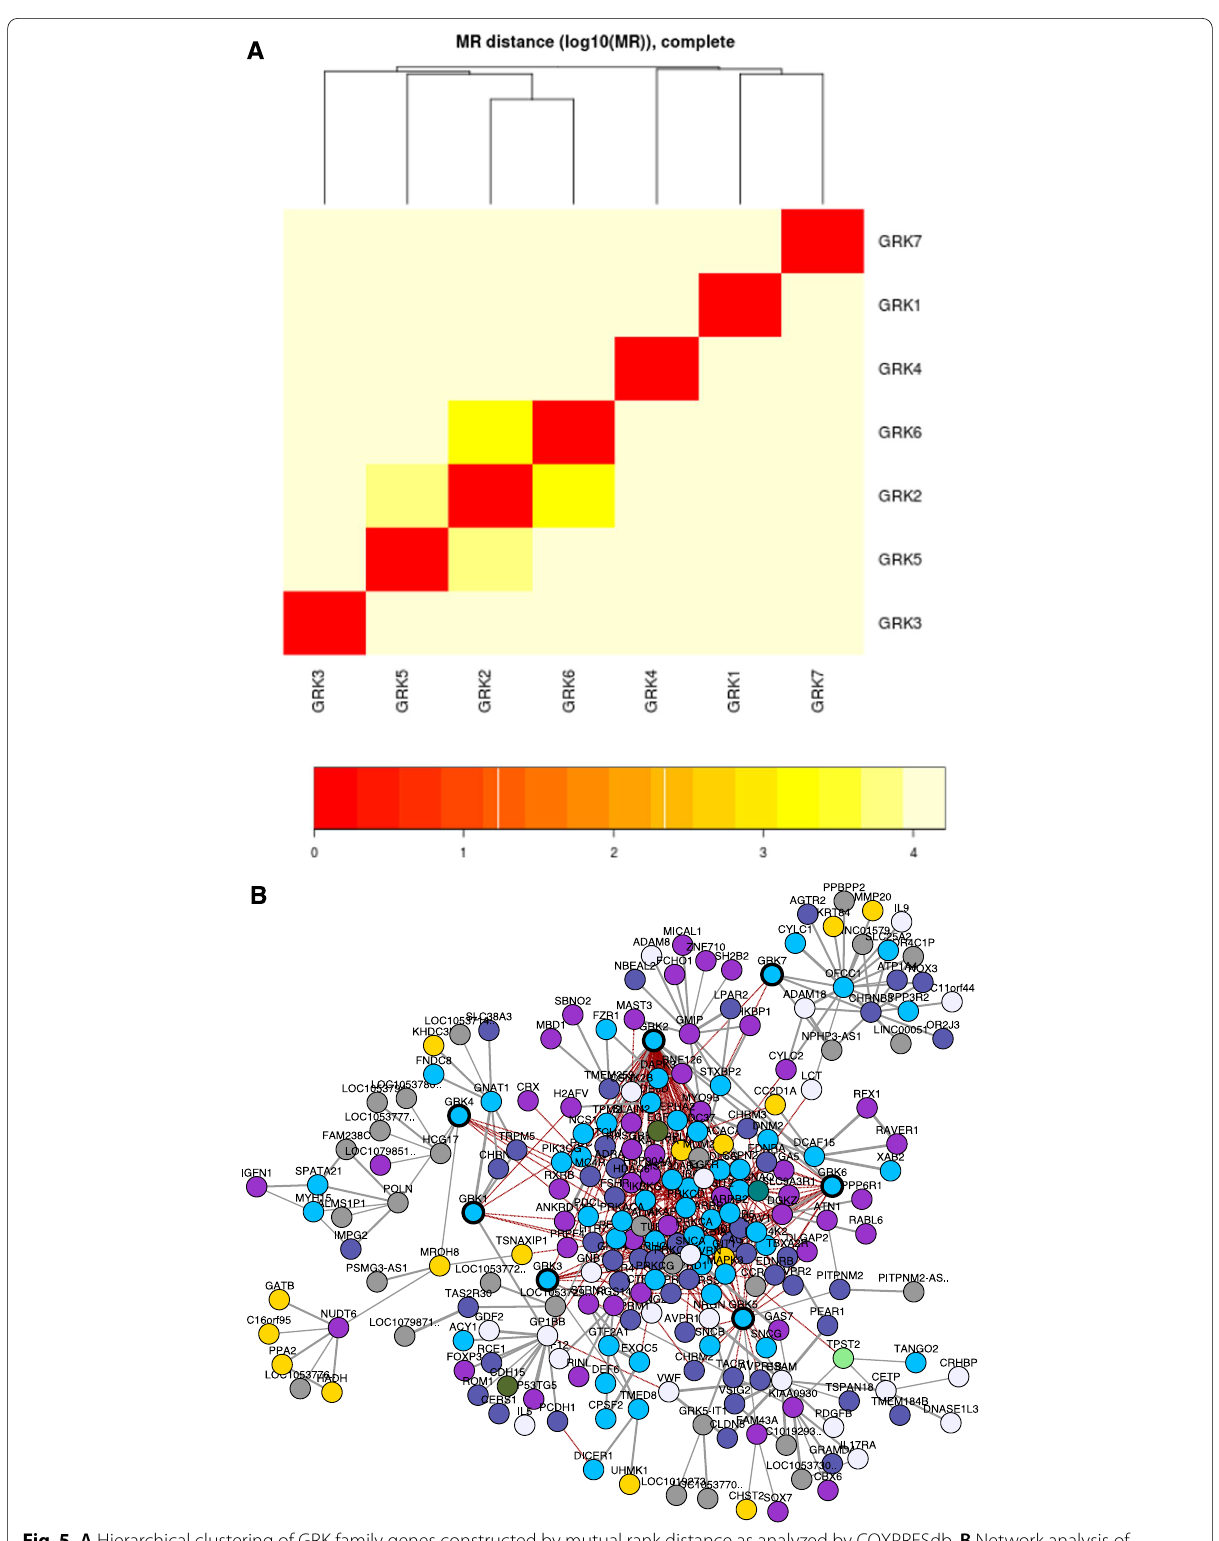
Fig. 5 A Hierarchical clustering of GRK family genes constructed by mutual rank distance as analyzed by COXPRESdb. B Network analysis of co-expressed genes related to GRKs as analyzed by COXPRESdb. C Gene ontology enrichment analysis of the co-expressed GRK genes as analyzed by WebGestalt. D KEGG pathway enrichment analysis of co-expressed GRK genes as analyzed by WebGestalt. E Drug–gene association analysis of co-expressed GRK genes as analyzed by